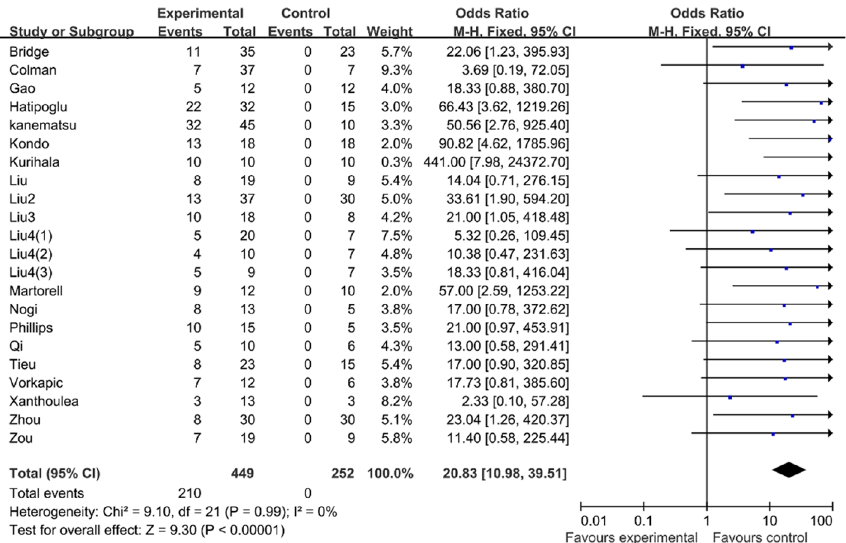
Table 2. AngII can successfully induce the formation of the aortic dissection in mice.